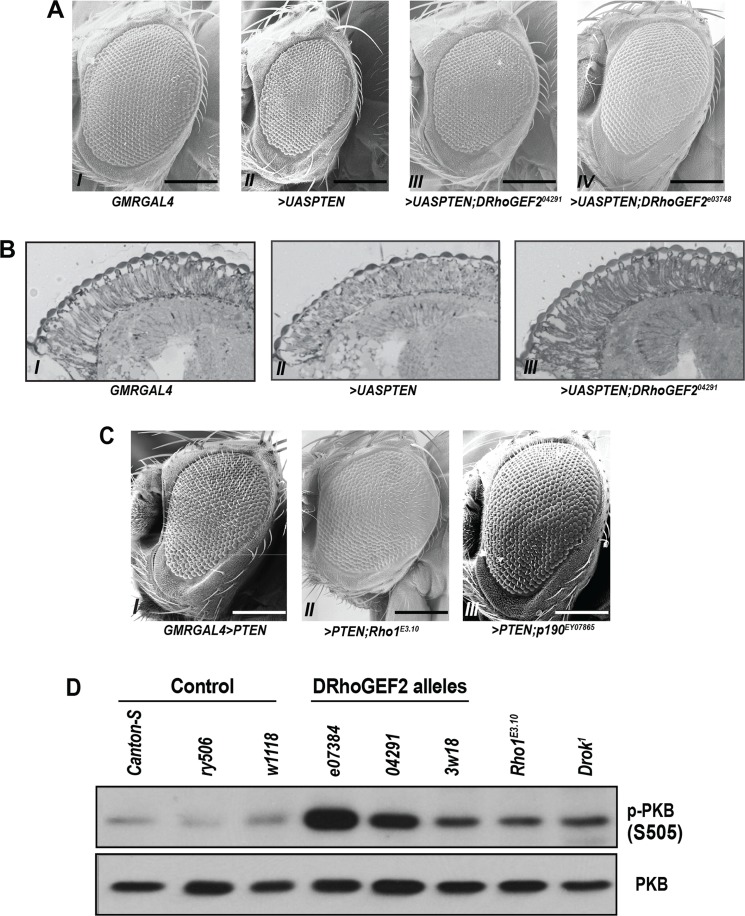
Rho signaling suppresses the PTEN-overexpression eye phenotype via dPKB/dAkt activation.(A) Scanning electronic micrograph of adult eyes from (I) GMR-GAL4/+, (II) GMR-GAL4>UAS-PTEN/CyO, (III) GMR-GAL4>UAS-PTEN/DRhoGEF204291, and (IV) GMR-GAL4>UAS-PTEN/DRhoGEF2e03784. Scale bar = 200 μm. (B) Toluidine blue-stained longitudinal retinal sections of adult eyes from (I) GMR-GAL4/+ and (II) GMR-GAL4>UAS-PTEN and (III) GMR-GAL4>UAS-PTEN/DRhoGEF204291. (C) Scanning electronic micrograph of adult eyes from (I) GMR-GAL>UAS-PTEN and (II) GMR-GAL4>UASPTEN/RhoE3.10. Scale bar = 200 m. μ(D) Scanning electronic micrograph of adult eyes from (I) GMR-GAL4>UAS-PTEN and (II) w67c23P{EPgy2}RhoGAPp190EY08765/+;GMR-GAL4>UAS-PTEN/+. Scale bar = 200 μm. (D) dPKB/dAkt phosphorylation in the 3rd instar larval eye discs from the wild type controls (Canton-S; ry506, and w1118) and the mutants (DRhoGEF204291/CyO, DRhoGEF2e0378/CyO, Rho1E3.10/CyO, and Drok1/FM7), representative of three independent experiments.